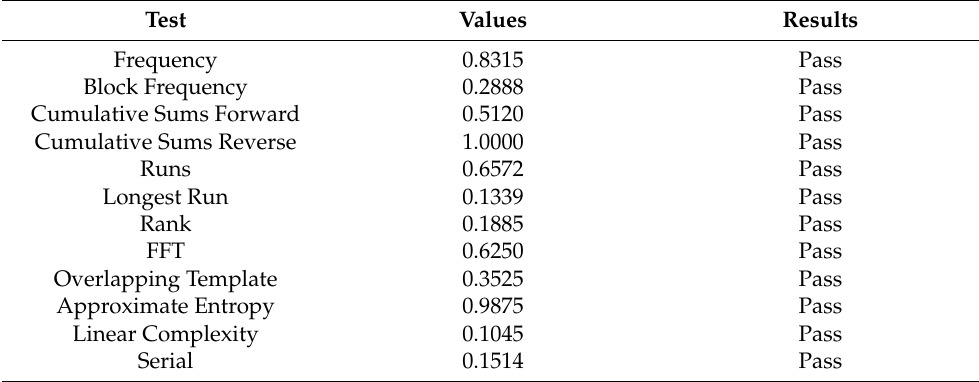
Table 6. NIST test results for the 5D Guass Map.